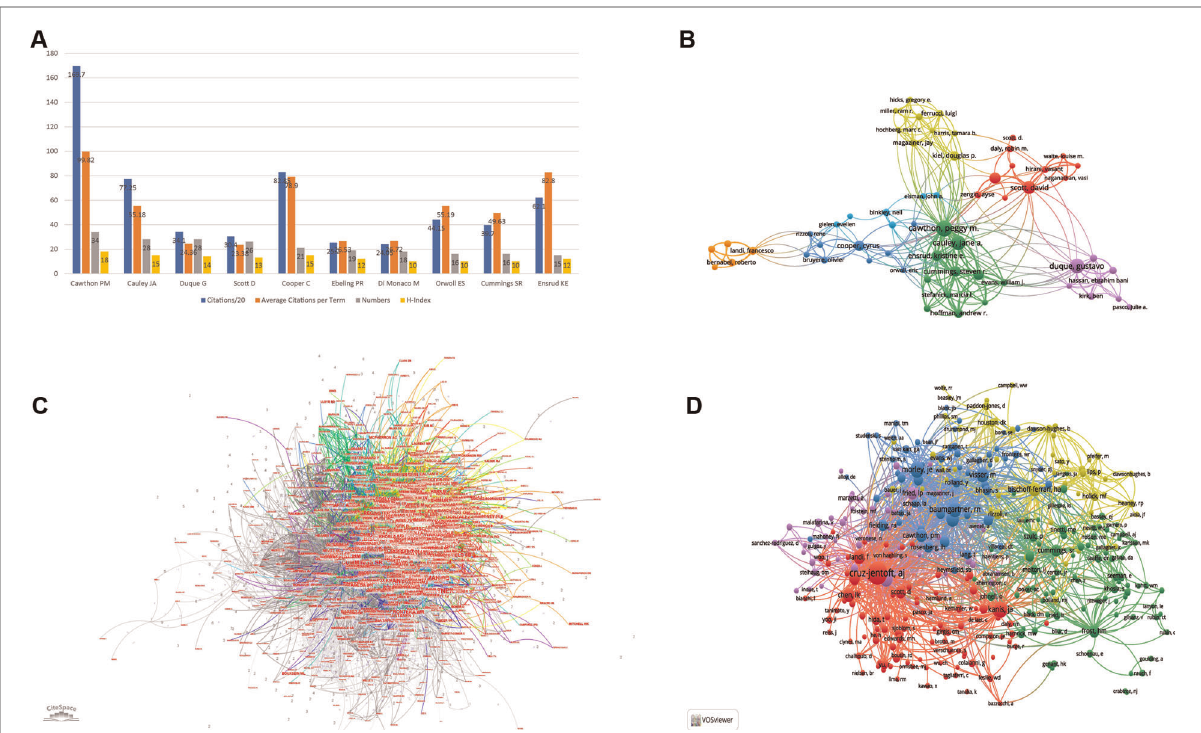
FIGURE 5 Analysis of authorships. ( A ) The general information of the top 10 productive authors with studies about sarcopenia and hip fractures in older patients; ( B ) network visualization map of collaboration between authors (generated by VOSviewer). The size of nodes is proportional to the collaboration frequency of authors, and the color of the lines between two nodes presents the collaboration relationship between authors. The thicker the lines between two nodes, the higher the frequency of their collaboration; ( C ) network visualization map of the cited relationship between authors (generated by Citespace); ( D ) network visualization map of co-cited authors (generated by VOSviewer). The size of nodes is proportional to the co-cited times of authors. The thicker the lines between two nodes, the higher the frequency of their co-citation.